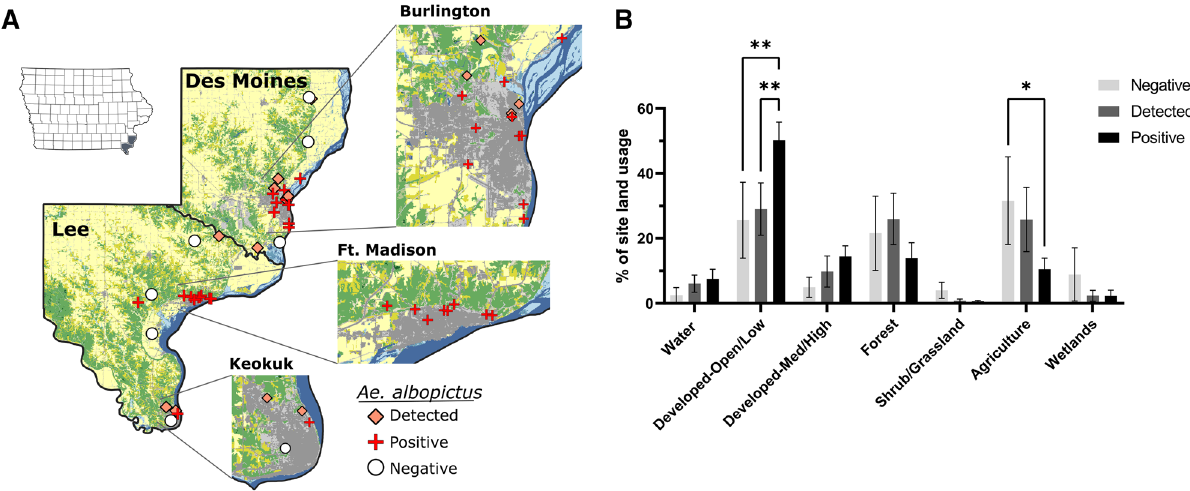
Figure 3. Landscape ecology influences Ae. albopictus abundance. Trapping site locations for both Des Moines and Lee counties display the presence/absence of Ae. albopictus as either positive (detected every year; red cross), detected (detected in some years; orange diamond), or negative (never detected; white circle) ( A ). Insets display expanded views for the most populous cities in Des Moines (Burlington) and Lee County (Ft. Madison and Keokuk). To better understand differences in the ecology of sites where Ae. albopictus were positive, detected, or negative, land use/land cover analysis was performed using 500 m radius around each trapping location and displayed for different land use/land cover classifications ( B ). Statistical analysis was performed using a 2-way ANOVA and a Tukey’s multiple comparison test using GraphPad Prism software. Asterisks denote significance (*p < 0.05; **p < 0.01). The map was created in QGIS version 3.14.1 (www. qgis. org) using an Iowa county boundary shapefile obtained from Iowa Geospatial Data (https:// geoda ta. iowa. gov) and land cover data obtained from the Multi-Resolution Land Characteristics Consortium (MRLC) National Land Cover Database (NLCD) (https:// www. mrlc. gov/). The image was produced using the layout manager tool within QGIS and edited using Inkscape (https:// inksc ape.